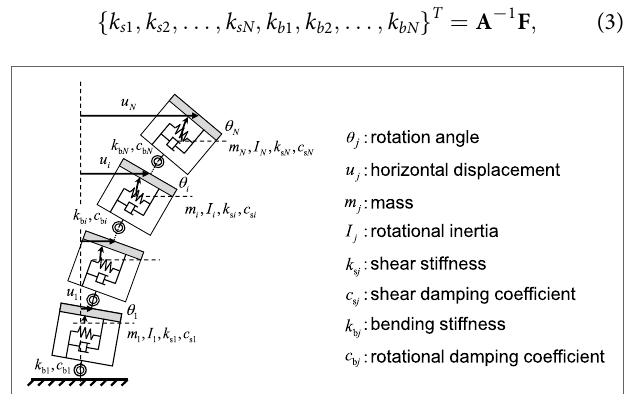
FIGURE 1 | Shear-bending model.